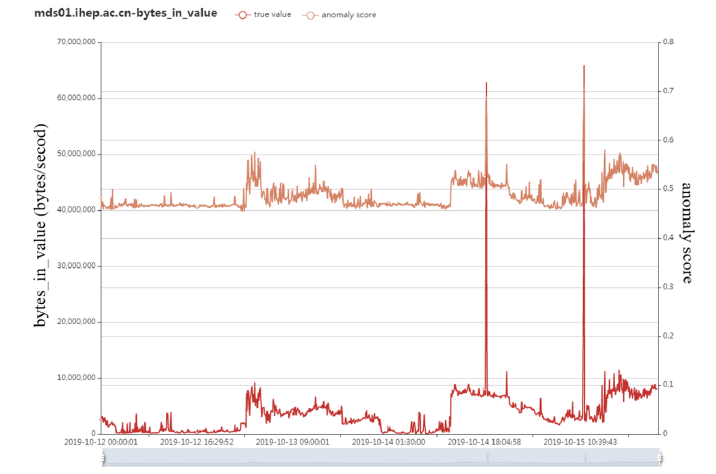
Figure 5. Result of spatial anomaly detection method. The red line shows true bytes_in_value of mds01.ihep.ac.cn. The orange line shows the anomaly score. There is no spatial anomaly